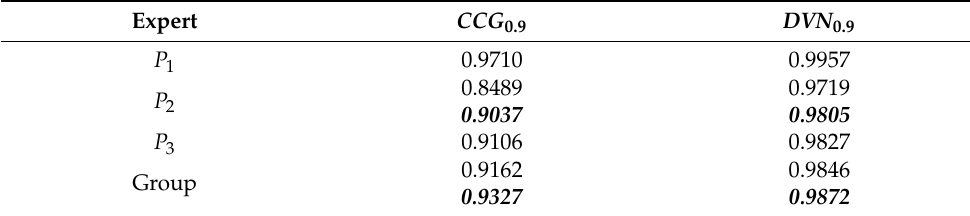
Table 7. Results of group consensus indices.